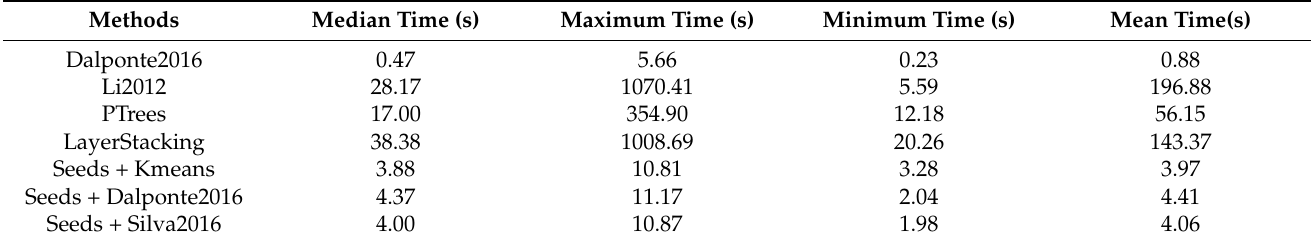
Figure 12. The refining process (iterative classification). The horizontal projection ( a ) and the vertical profile ( b ) of the core trees (purple and yellow) and the neighbor points (black) with the eps setting of 0.4. ( c ) The reclassification results using the iterative classification process. ( d ) A new iteration with the eps set to 0.55. Table 6. The descriptive statistics of the processing time of all the sample plots for the four direct ITS methods and the three seed points based ITS